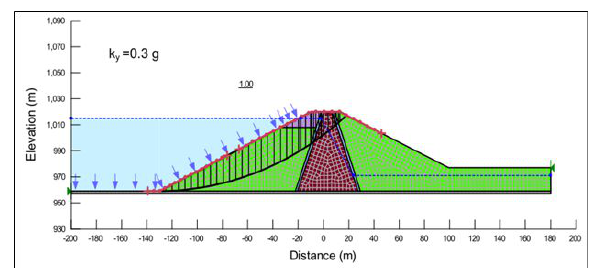
Fig. 8. Critical Slip Surface of Upstream Slope.